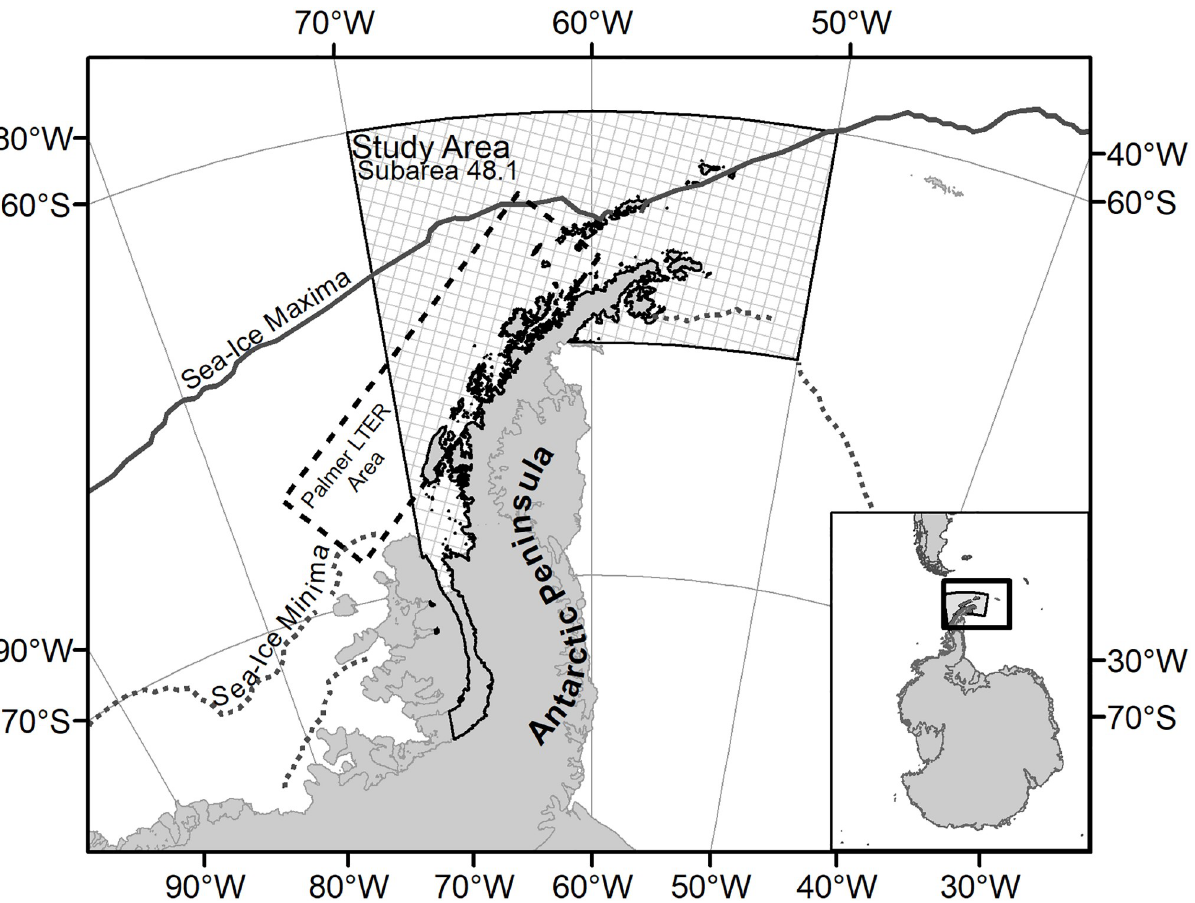
Fig 1. Study area detail. Map, including reticules, was created using ArcMap 10.6. The Antarctic continent shapefile is freely available from the Antarctic Digital Database [26], the boundary of Statistical Area 48.1 is freely available from CCAMLR’s online GIS [27]. The Natural Earth (https:// www.naturalearthdata.com/) provides public domain shapefiles of the countries of the world. The polygon bounding the Palmer LTER Study Area was drawn to bound the stations identified in the Palmer LTER Basic Grid[28] The displayed sea-ice maxima is a climatology (1981–2010) describing the median location of the sea edge in the month of August as made available from the National Snow and Ice Data Center [29]. The displayed sea-ice minima is a climatology (1981–2010) describing the median location of the sea ice edge in February as made available from the National Snow and Ice Data Center